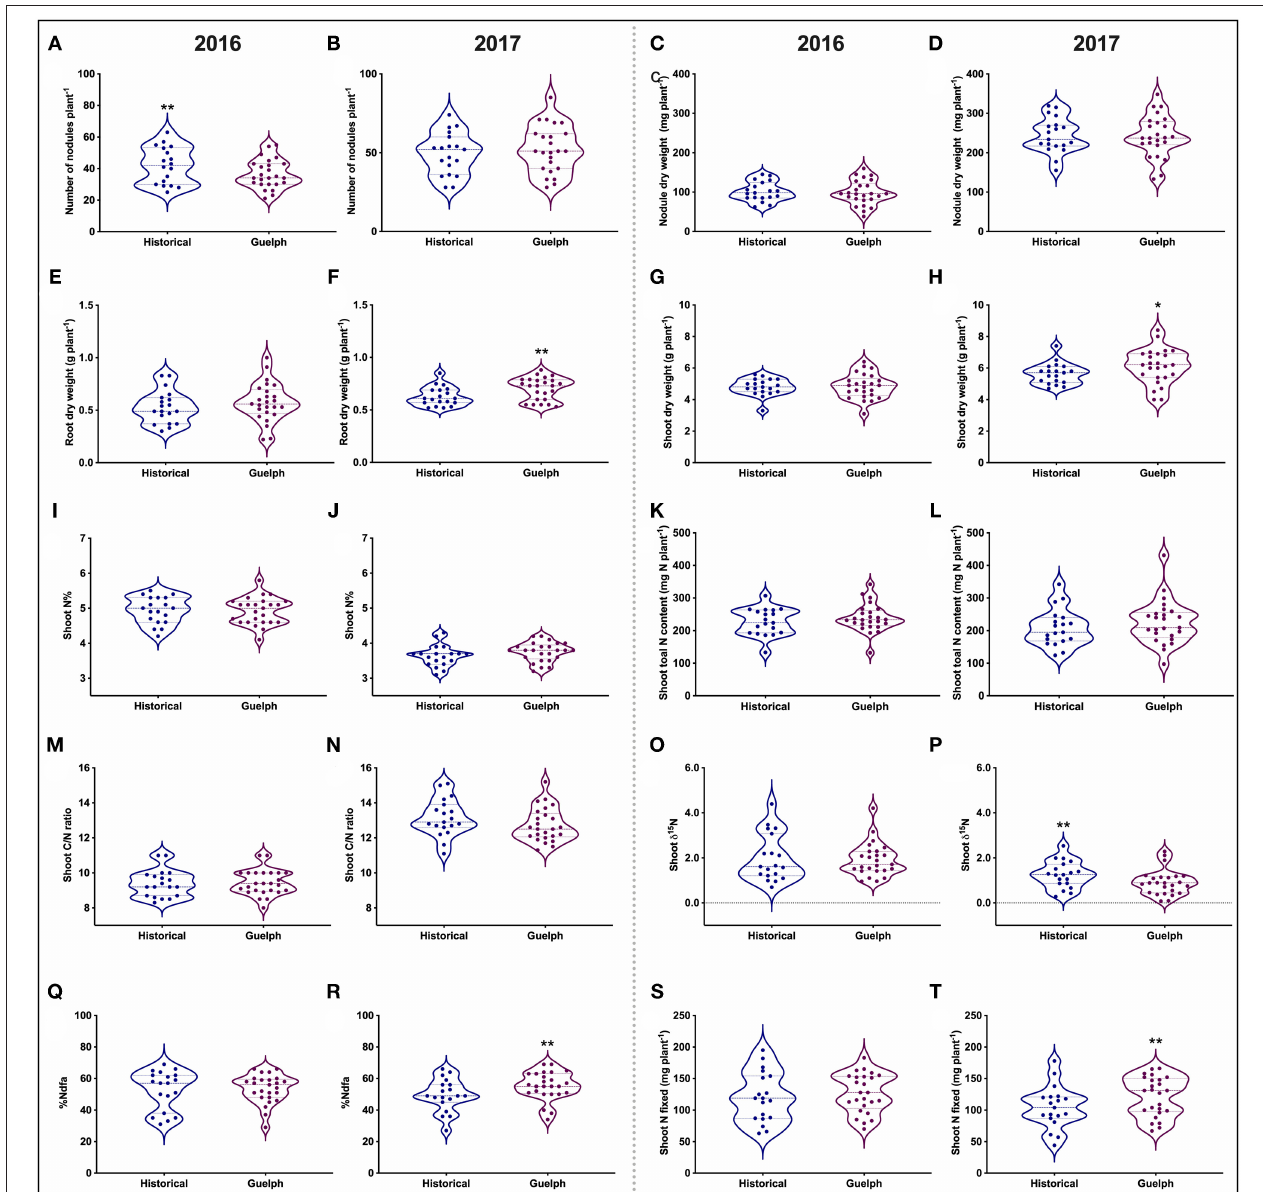
FIGURE 2 | Distribution of SNF-related traits in historical and modern-Guelph lines in 2016 and 2017 prior to pod-fill. (A,B) Number of nodules per plant. (C,D) Nodule dry weight per plant. (E,F) Root dry weight per plant. (G,H) Shoot dry weight per plant. (I,J) Shoot nitrogen percentage. (K,L) Shoot total nitrogen content per plant. (M,N) Shoot C/N ratio. (O,P) Shoot δ 15 N. (Q,R) Percentage nitrogen derived from the atmosphere (%Ndfa). (S,T) Shoot nitrogen fixed per plant. Each data point represents the mean value of a single cultivar. The asterisks (*, **) indicate significant difference between the 19 historical and 25 modern-Guelph cultivars at p < 0.05 and p < 0.01,